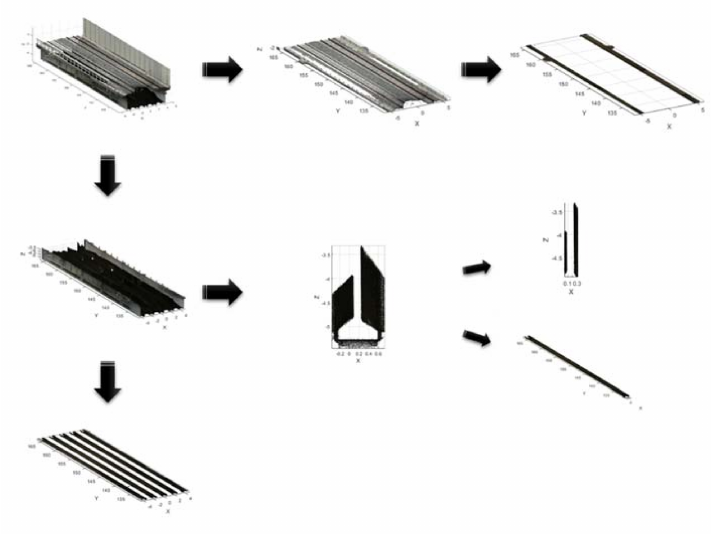
Figure 25. PCD decomposition for the Osong test track fifth